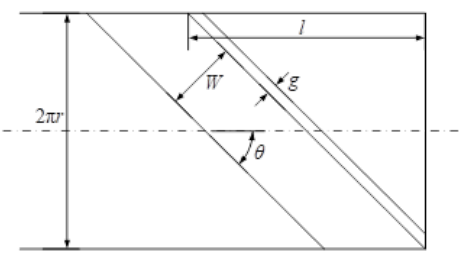
Figure 6. Schematic diagram of the conductor layer. Figure 6 . Schematic diagram of the conductor layer.